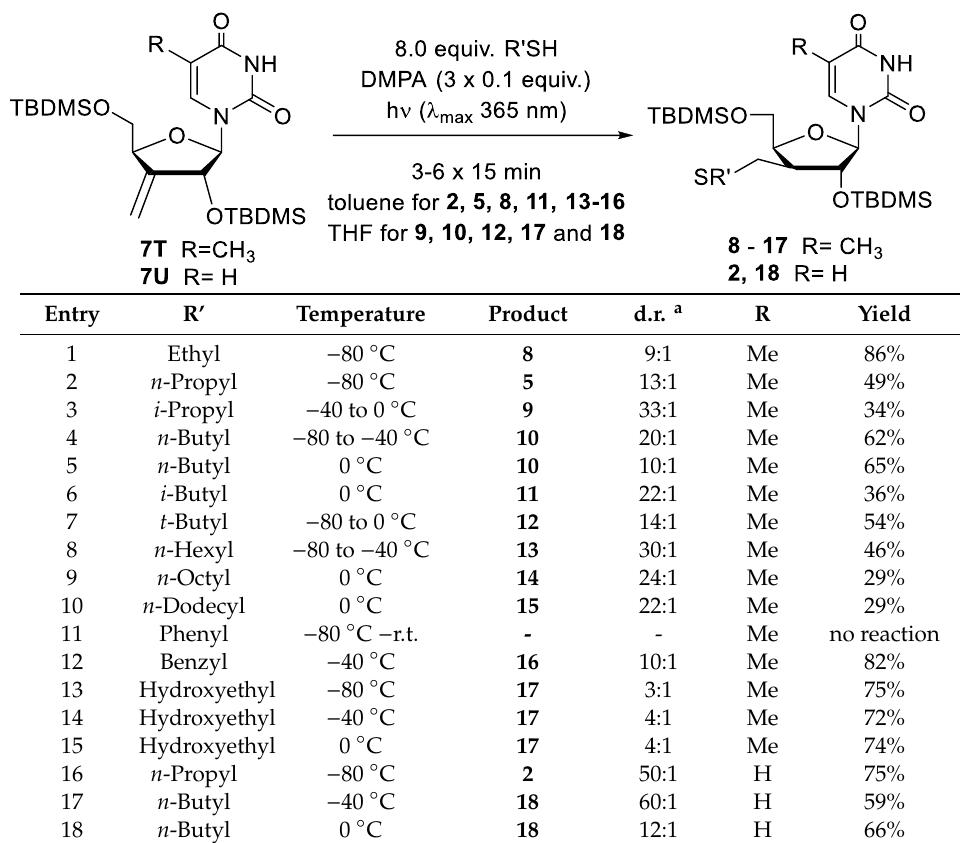
Table 1 . Photoinitiated additions of thiols onto 7T and 7U . Table 1. Photoinitiated additions of thiols onto 7T and 7U .